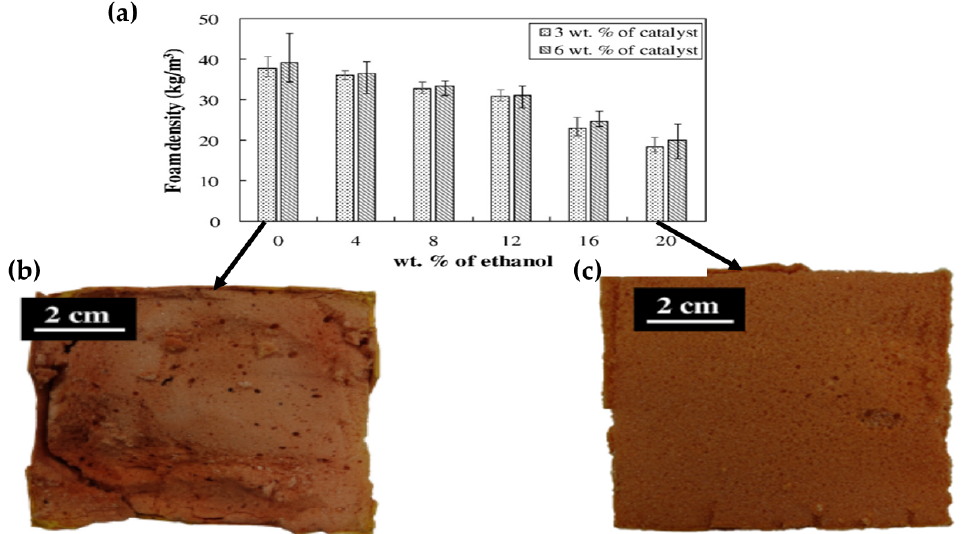
Figure 10. ( a ) Free rise phenolic foam density concerning the wt.% of ethanol; ( b and c ) photographs of the phenolic foams’ cross-sectional views with three wt.% of PTSA catalyst concerning the wt.% of ethanol, 0 wt%, and 20 wt%. Reprinted with permission from the authors of [47]. Copyright © (2016) Elsevier.